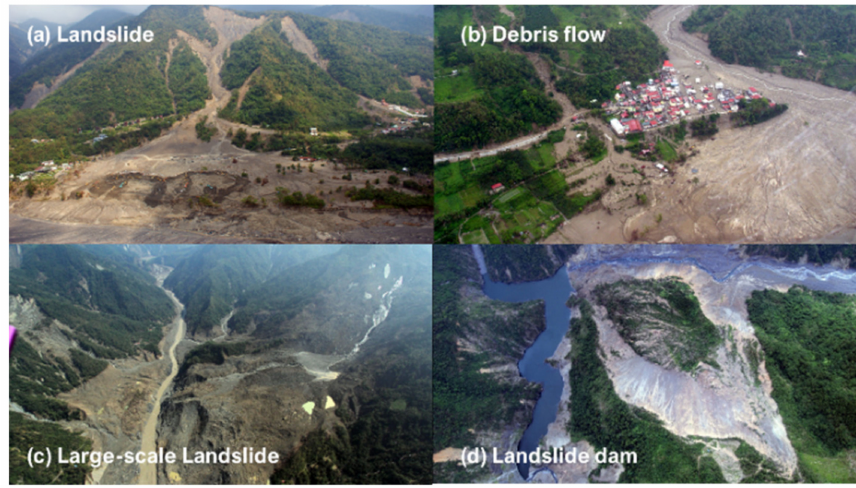
Figure 1. Landslide disasters occurred during Typhoon Morakot in Taiwan: ( a ) Landslide; ( b ) Debris flow; ( c ) Large-scale Landslide; ( d ) Landslide dam.